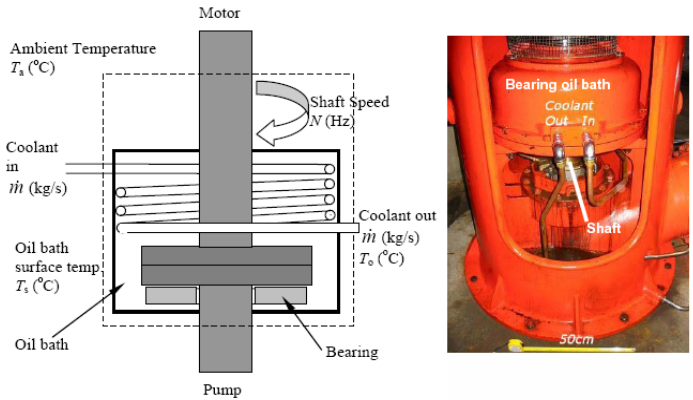
Figure 3. Detail of the shaft coupling.